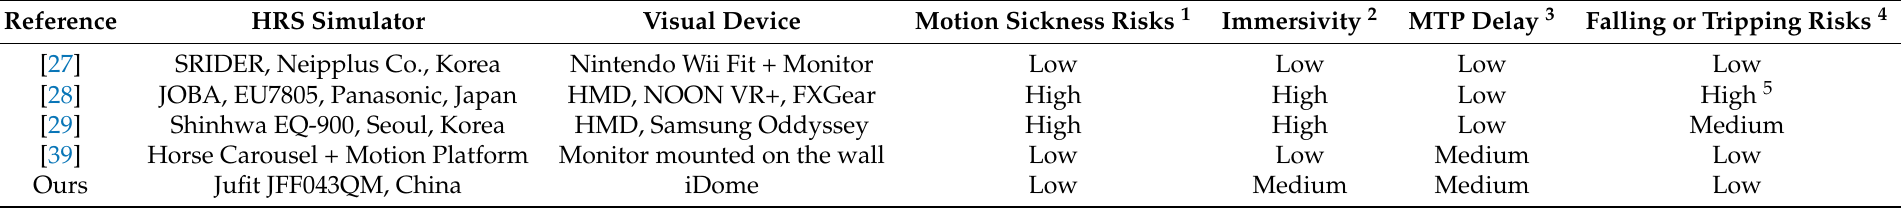
Table 4. Comparison of others’ similar works to